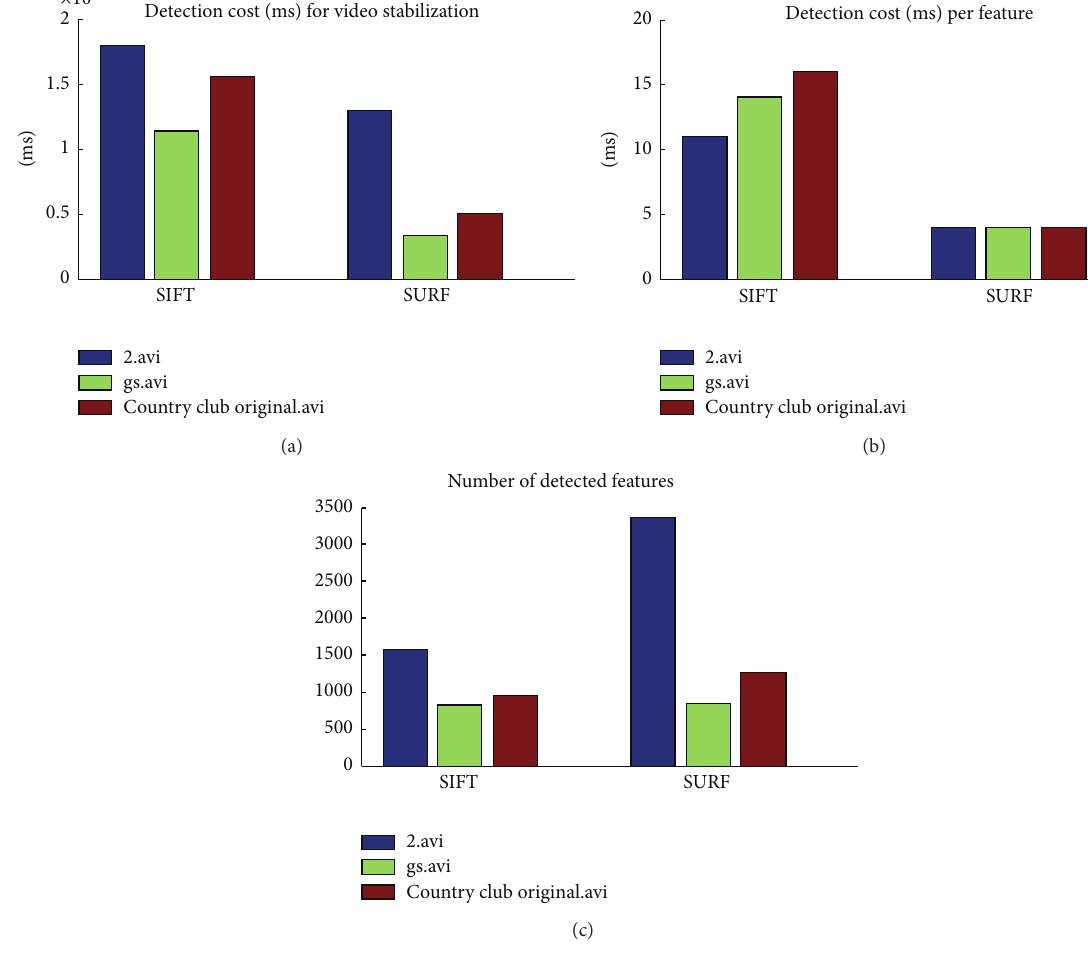
Figure 13: Performance